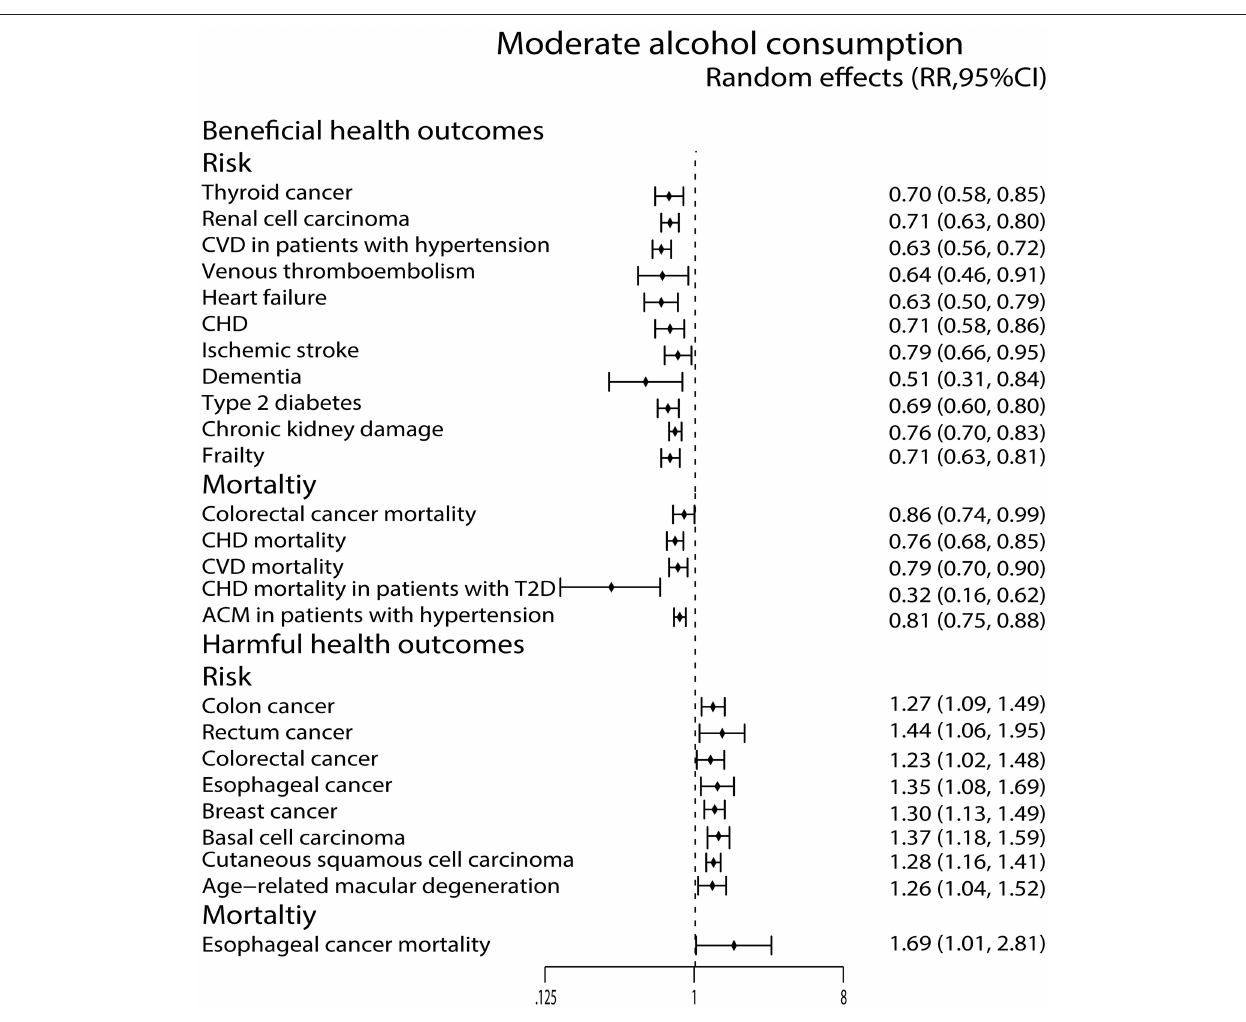
mortality (9), a 31% reduction in CHD mortality in patients with T2D (49) and a 19% reduction in all-cause mortality (ACM)